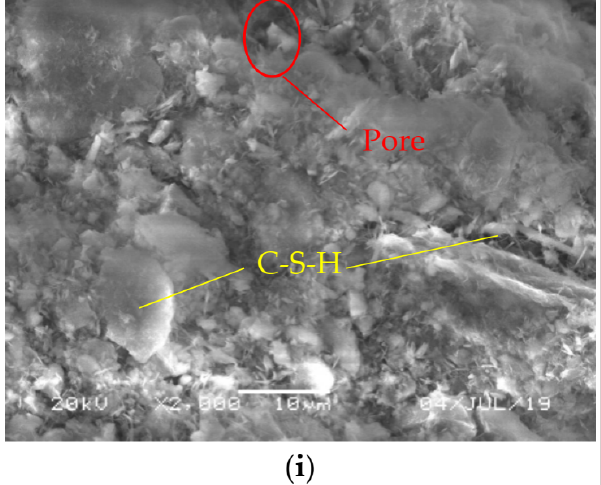
Figure 7. SEM images of the FCMS with different fiber content after several different F–T cycles. ( a ) 0% fiber content 0 F–T cycles; ( b ) 0% fiber content 5 F–T cycles; ( c ) 0% fiber content 10 F–T cycles; ( d ) 0.5% fiber content 0 F–T cycles; ( e ) 0.5% fiber content 5 F–T cycles; ( f ) 0.5% fiber content 10 F–T cycles; ( g ) 1% fiber content 0 F–T cycles; ( h ) 1% fiber content 5 F–T cycles; ( i ) 1% fiber content 10 F–T